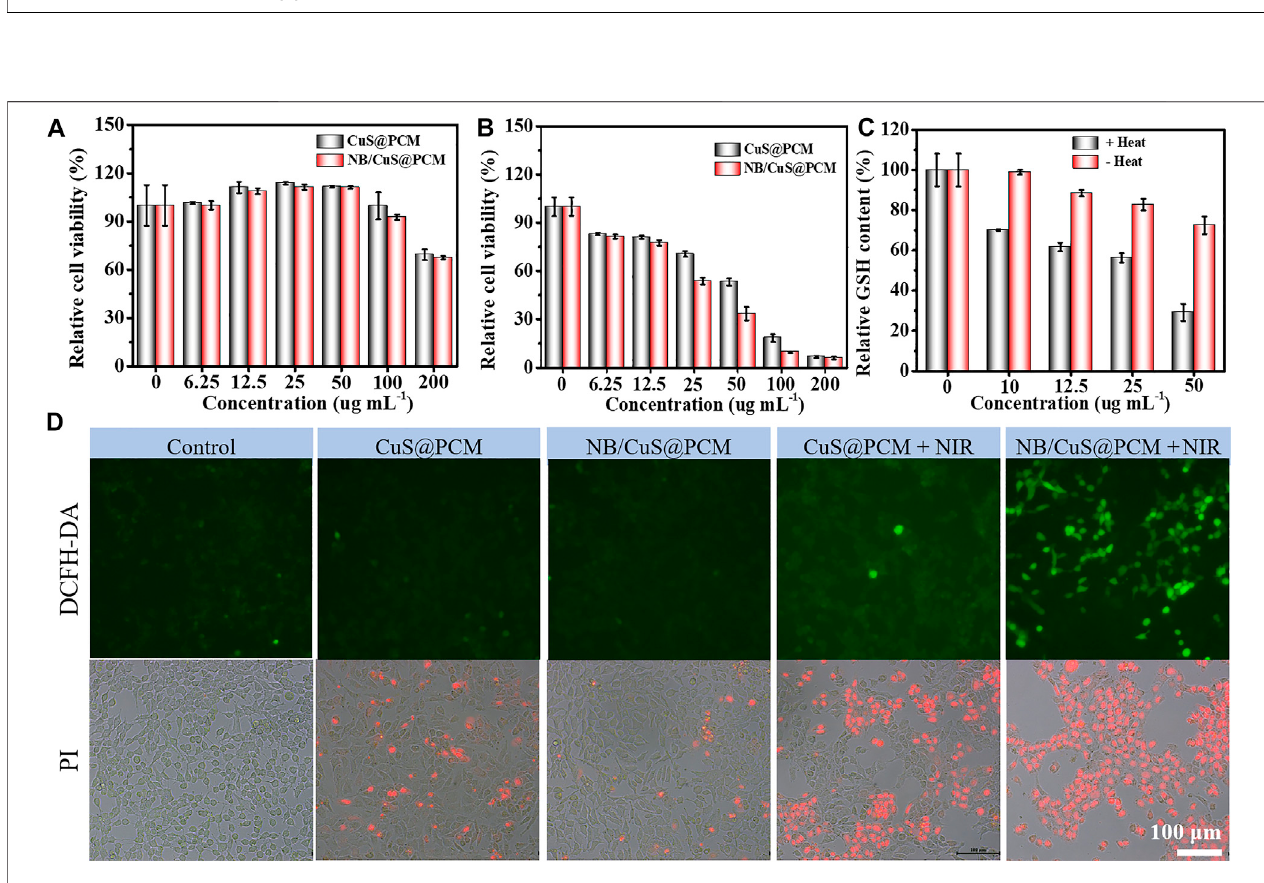
FIGURE 3 | (A) Cytocompatibility assay. (B) Cytotoxicity assay of NPs under laser exposure. (C) Intracellular GSH-depleting capability of NB/CuS@PCM NPs. (D) Intracellular ROS content assay using DCFH-DA probe (green fl uorescence). Cell death staining analysis using PI probe (red fl uorescence).